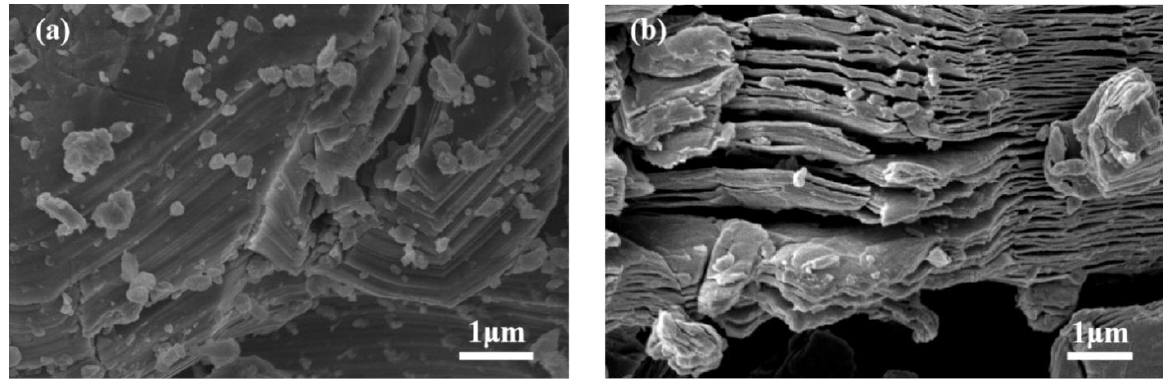
Figure 1. SEM images of ( a ) Ti 3 AlC 2 and ( b ) Ti 3 C 2 T x before and after etching.